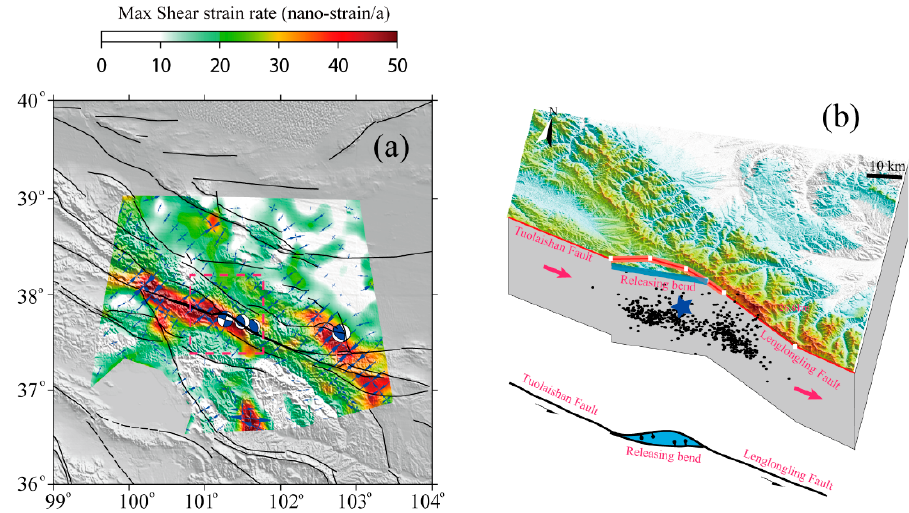
Figure 12. Distribution of the maximum shear strain rates ( a ) and a schematic diagram of the stepover zone between the Tuolaishan and Lenglongling faults ( b ). In ( a ), black curves indicate active faults and the bold curve indicates the fault segment. Blue focal mechanism solutions are (from left to right) for the 2022 Menyuan earthquake, the 1986 Menyuan earthquake, the 2016 Menyuan earthquake, and the 1927 Gulang earthquake. The blue arrow indicates the magnitude and direction of the principal strain rate while the red-dashed line indicates the zone of ( b ). In ( b ), the thin red lines indicate the locations of the active faults and the thick red line is the rupture and deformation trace of the 2022 Menyuan earthquake. The thick blue line represents the aftershock trace after relocation while the black dots indicate the aftershock distribution. The blue star indicates the epicenter of the 2022 Menyuan earthquake.